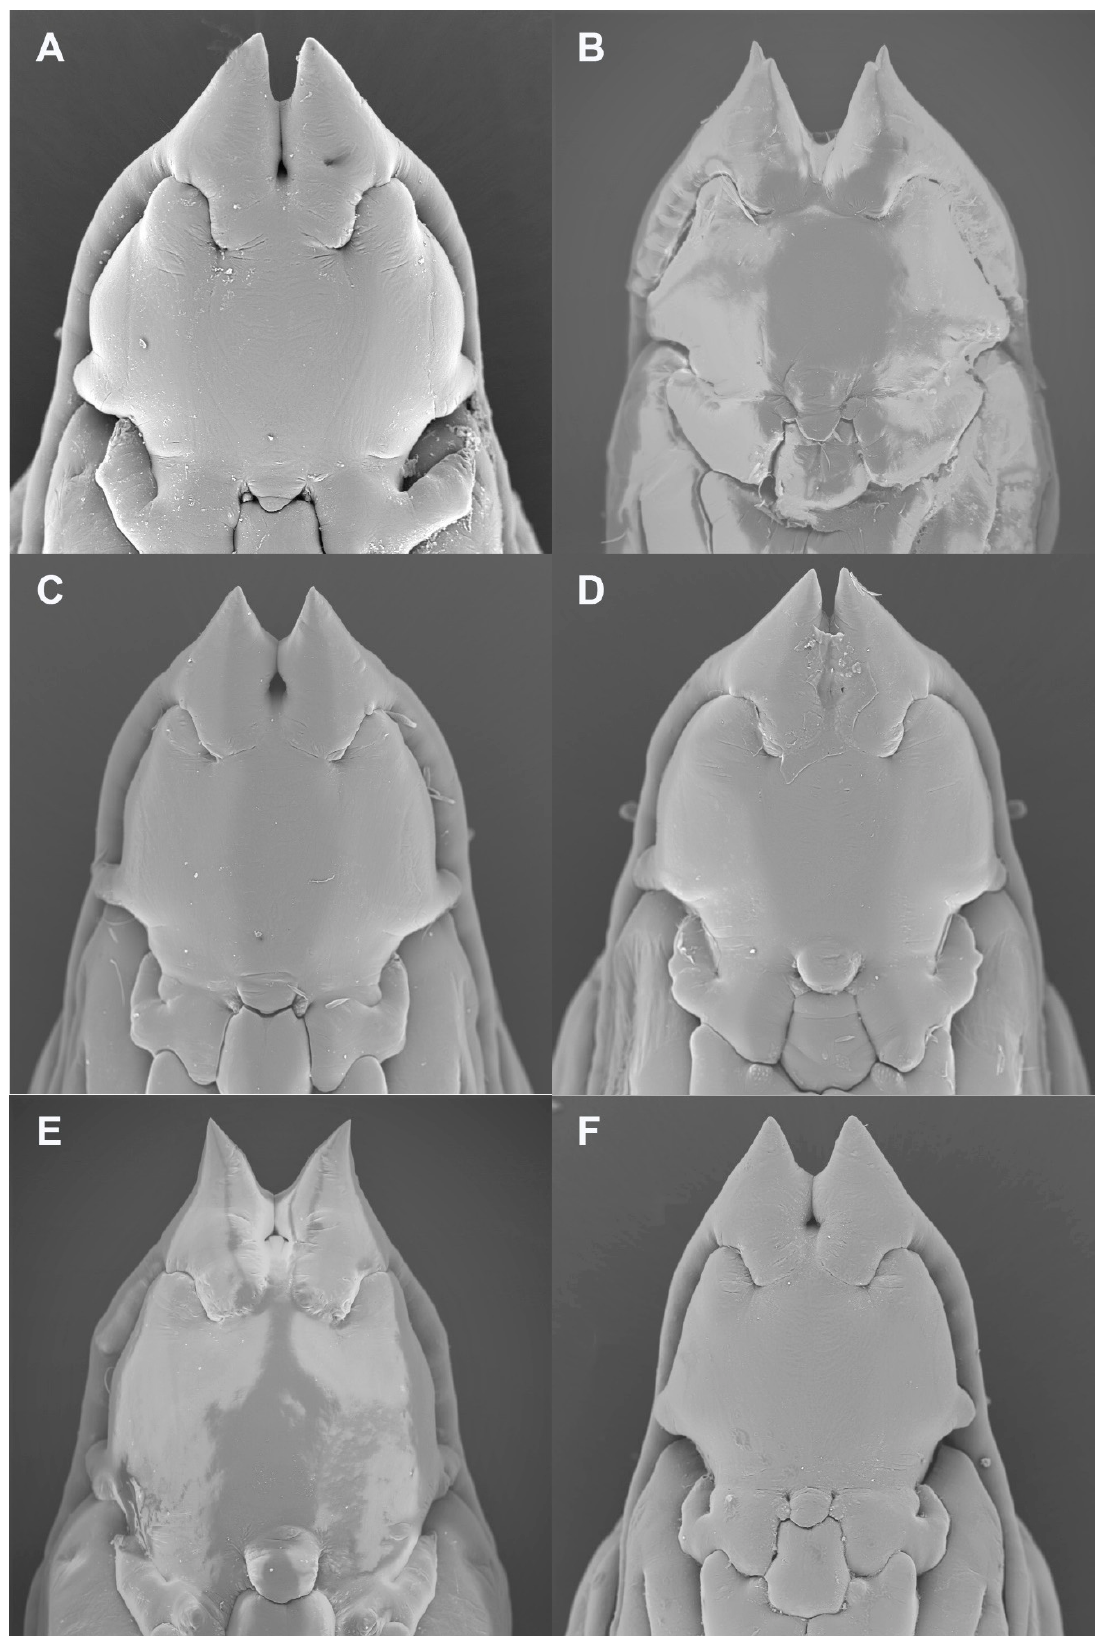
Figure 7. Ruschiola pupal heads, frontal. ( A ) R. succulenta . ( B ) R. attenuata . ( C ) R. cedarbergensis . ( D ) R. namaqua . ( E ) R. bubonis . ( F ) R. leipoldtiae .